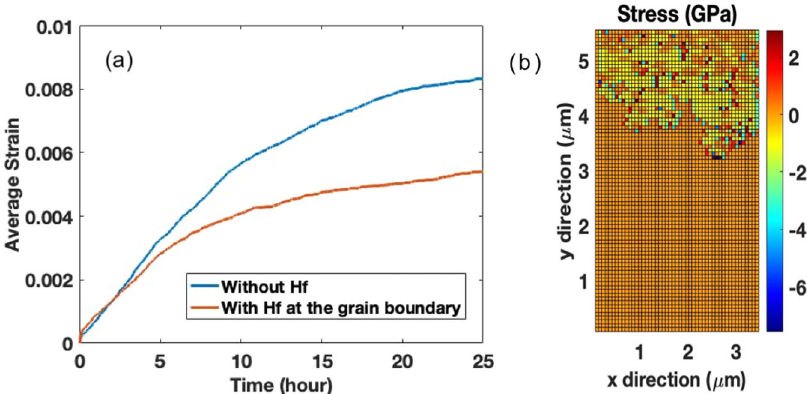
Fig. 9 Strain and stress in NiAl during oxidation at 1200 °C. a Magnitude of the strains calculated from the model with and without Hf doping and b stress contour with Hf addition.